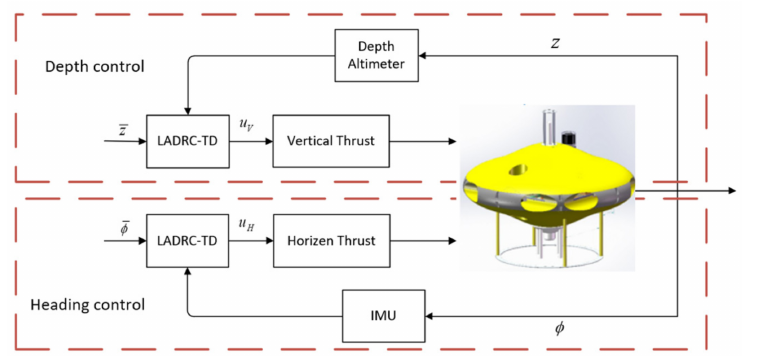
Figure 6. Block diagram of LADRC-TD.